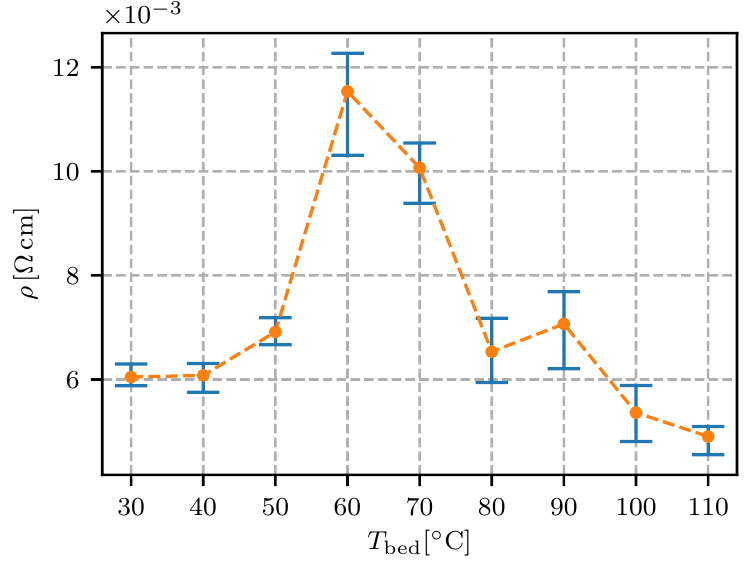
Figure 16. Resistivity for different print-bed temperatures T bed